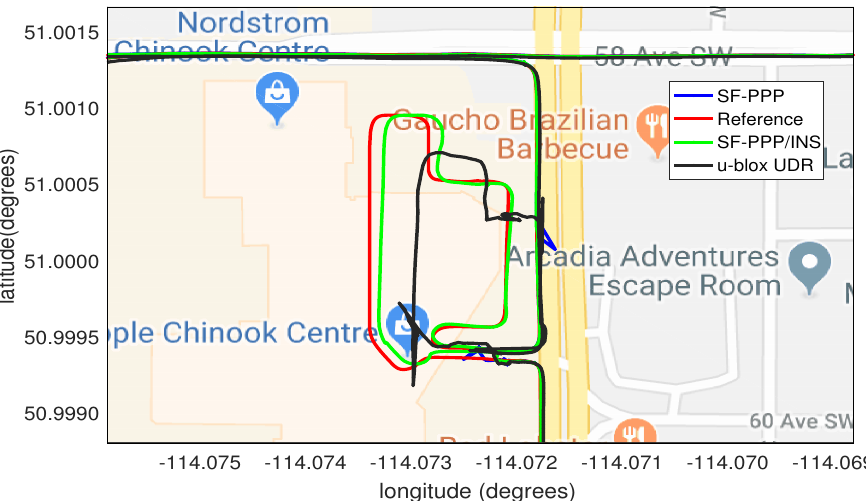
Figure 13. Navigation performance comparison between developed SF-PPP/INS and u-blox UDR in underground parking for 3